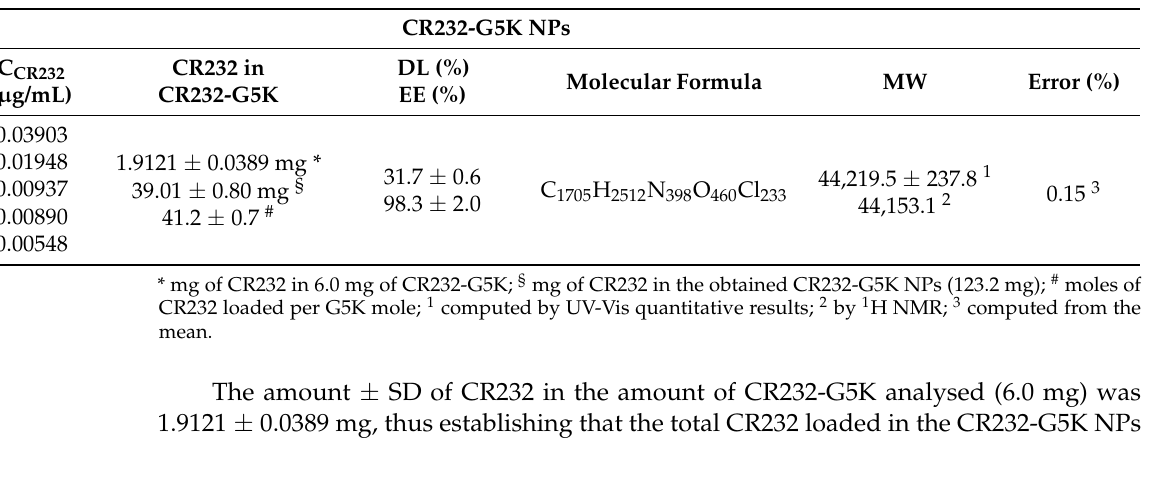
Table 3. Values of [A] obtained for the five concentrations of CR232-G5K NPs analysed and the related C CR232 obtained from Equation (1). Results concerning the content of CR232 in CR232-G5K NPs and DL% and EE%. Molecular formula and MW of CR232-loaded NPs, as well as the error (%) between the MW obtained by 1 H NMR and that computed using